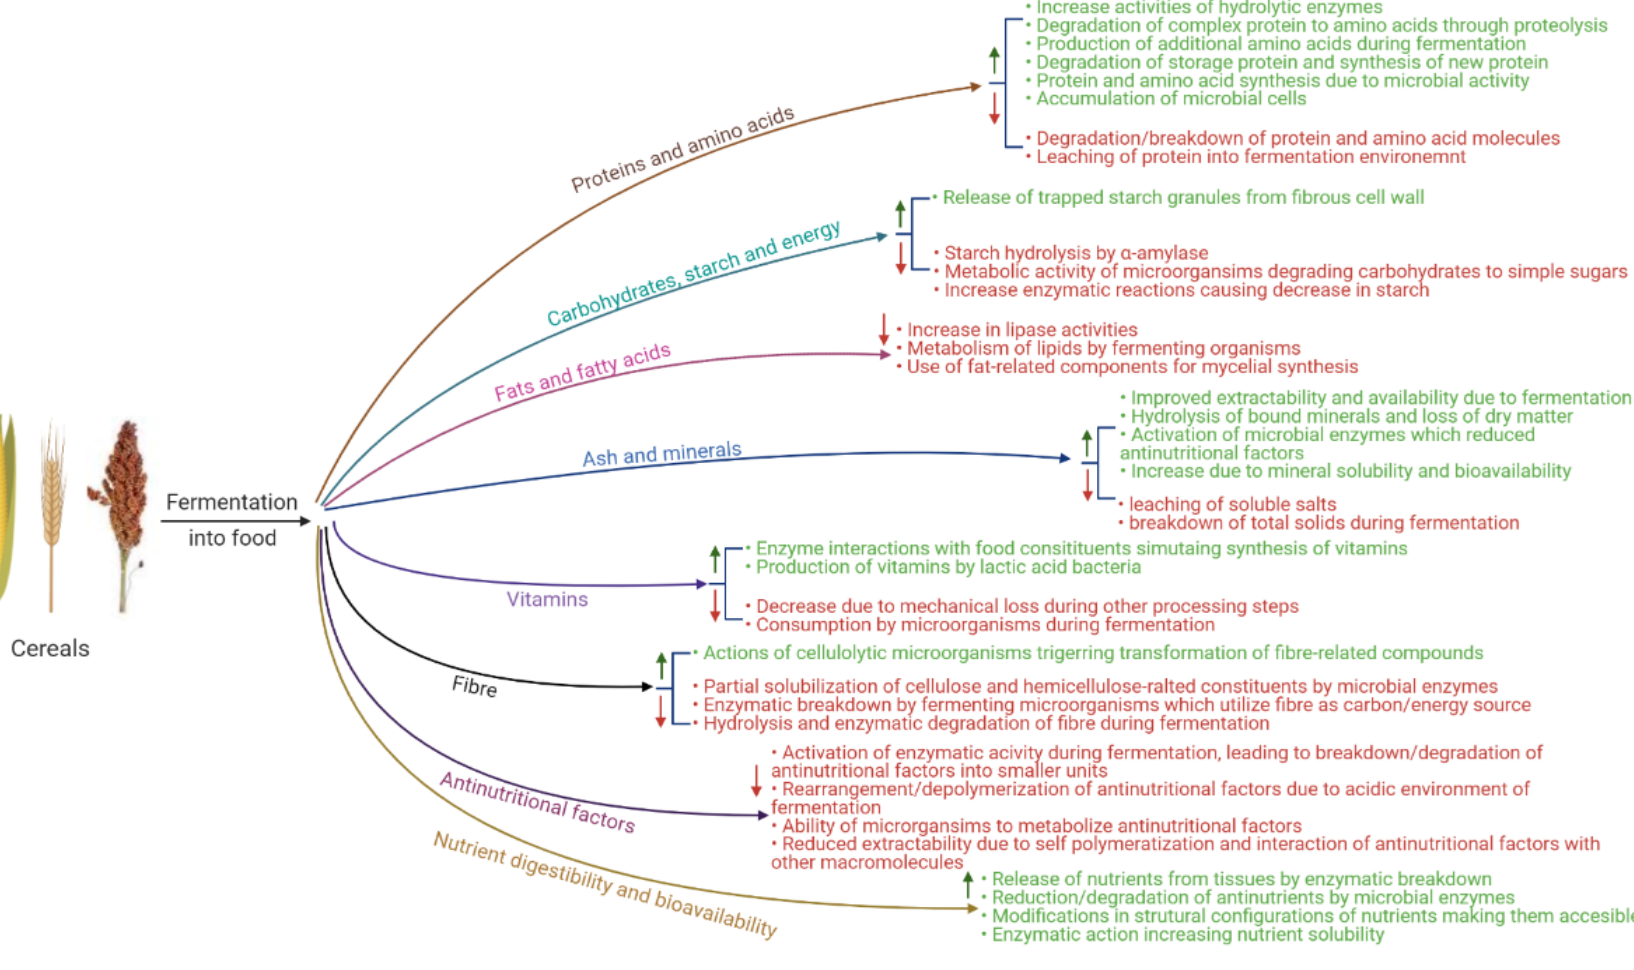
Figure 1. A summarized mechanisms of nutrient modifications in fermented cereals.